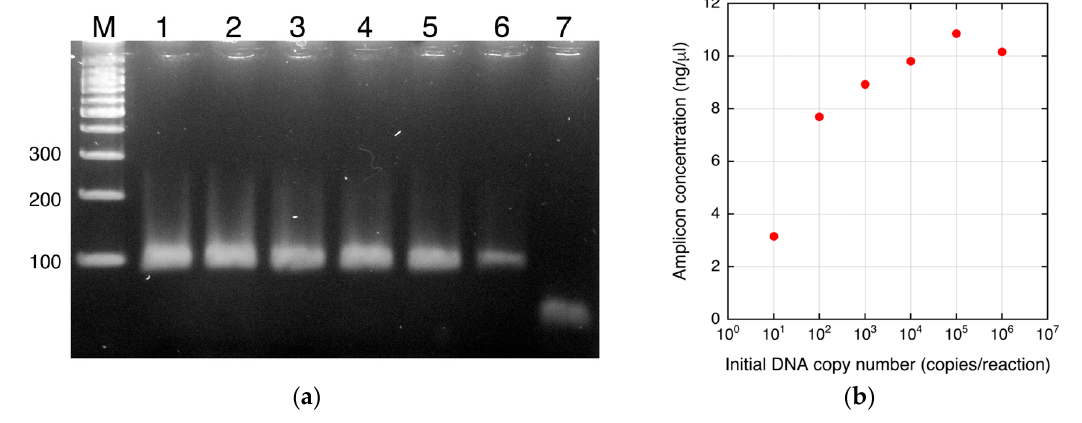
Figure 6. Amplicons of real-time PCR. ( a ) Agarose gel electrophoresis of the amplicons of real-time PCR (Figure 4a,b). M, molecular weight marker; 1–7, amplicons from initial copy numbers of 10 6 –10 0 . ( b ) Plot of the concentration of the amplicons as a function of the initial DNA copy number.